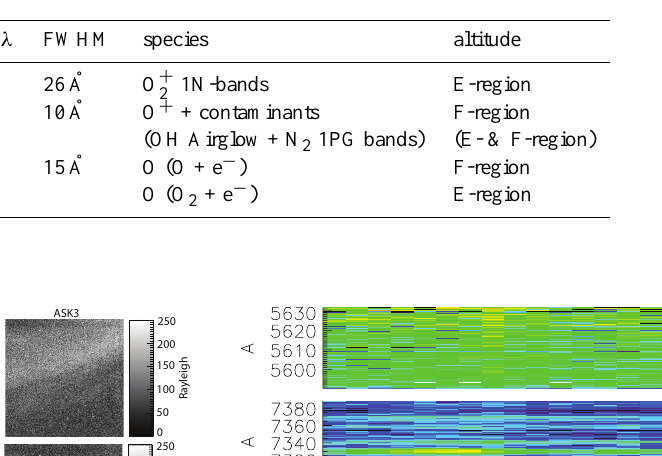
Table 1. The characteristics of the three passband filters in ASK.